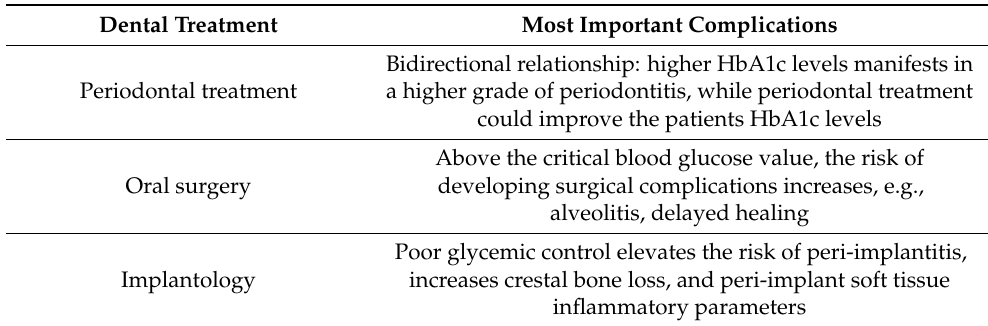
Table 2. Possible complications of high glycemic levels. Dental Treatment Most Important Complications Bidirectional relationship: higher HbA1c levels manifests in Periodontal treatment a higher grade of periodontitis, while periodontal treatment could improve the patients HbA1c levels Above the critical blood glucose value, the risk of Oral surgery developing surgical complications increases, e.g., alveolitis, delayed healing